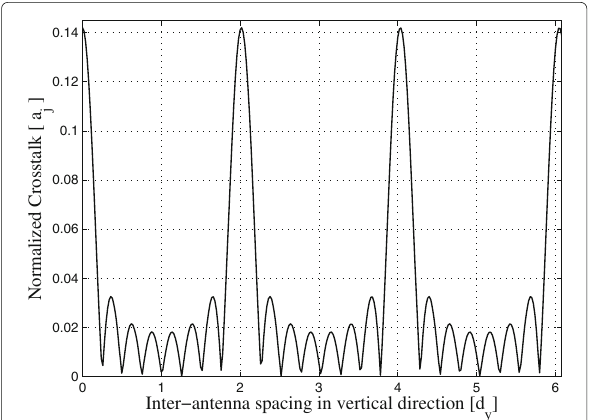
Fig. 3 The normalized crosstalk versus inter-antenna spacing in the vertical